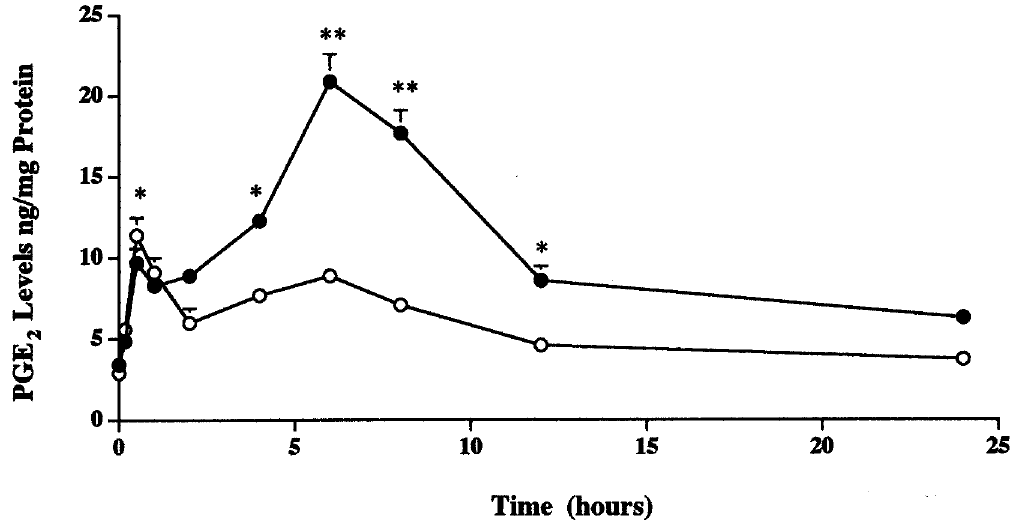
FIG. 8. Levels of PGE 2 in ( d ) cells treated with IL-1 b (10ng/ml) as compared with ( s ) cells treated with the IL-1 b and COX-2 synthesis inhibitor L-745,337. * P <0.05; P value represents the comparison of the effect of IL-1 b on PGE 2 production as compared with COX-2 inhibitor treated cells. Data are means±SE for four separate